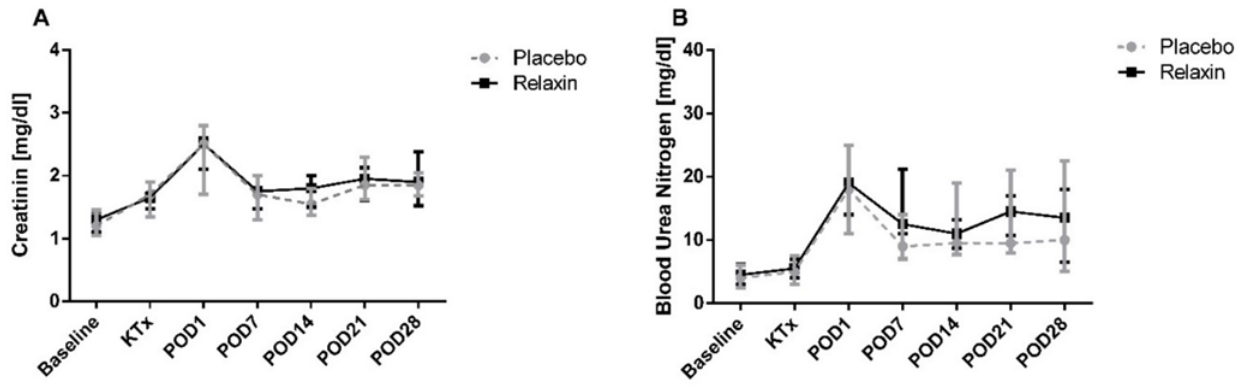
Figure 7. Plasma creatinine ( A ) and blood urea nitrogen ( B ) levels after kidney transplantation in Placebo and Relaxin groups. POD: postoperative day.